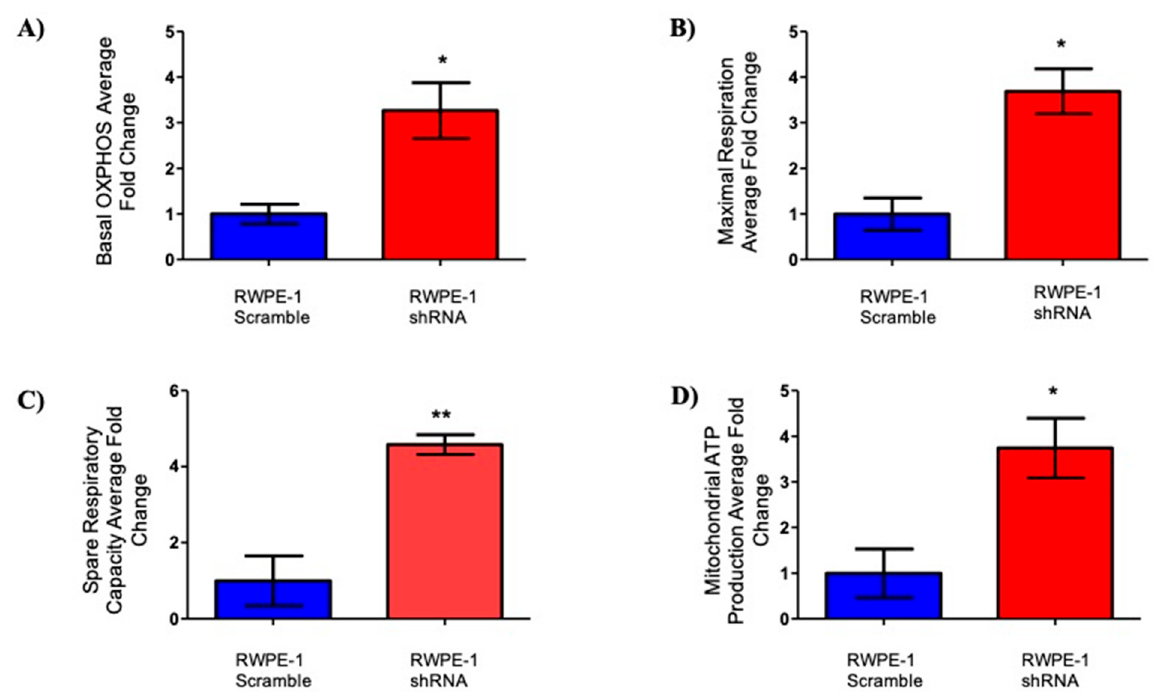
Figure 5. Reduction of SELENOF increases oxygen consumption in RWPE-1 cells. Average fold changes are represented for ( A ) basal, ( B ) maximal respiration after FCCP injection, ( C ) spare respiratory capacity (difference in peak OCR and basal measurements), and ( D ) mitochondrial ATP production (difference before and after oligomycin injection). Data are presented as the mean ± SEM, n =3, two-tailed paired t -test, * p < 0.05, ** p < 0.01, n = 3.